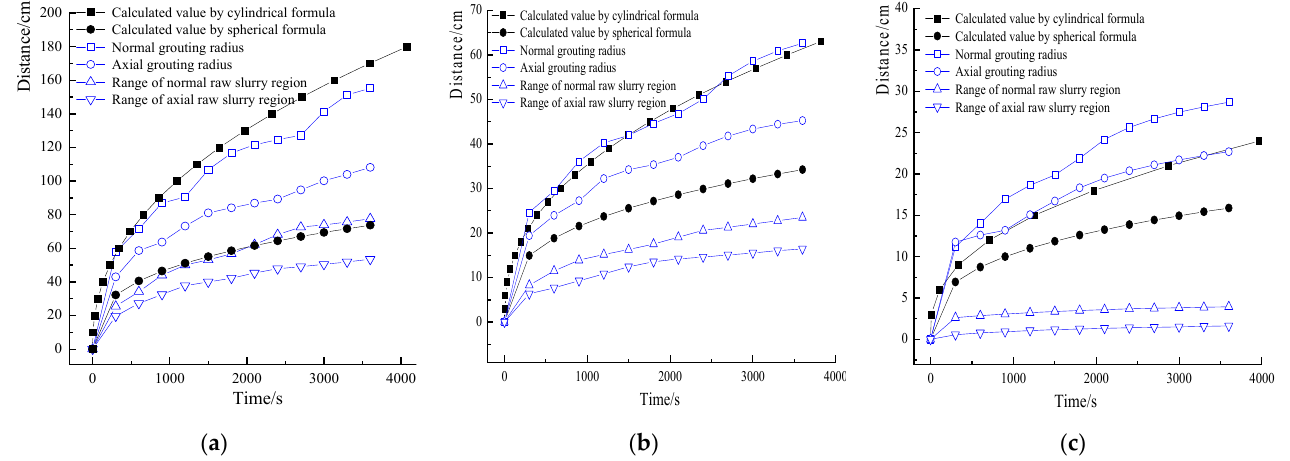
Figure 8. Comparison between numerically simulated values and theoretically calculated values of grouting radius at distinct initial permeabilities; ( a ) 5D; ( b ) 0.5D; ( c ) 0.05D.